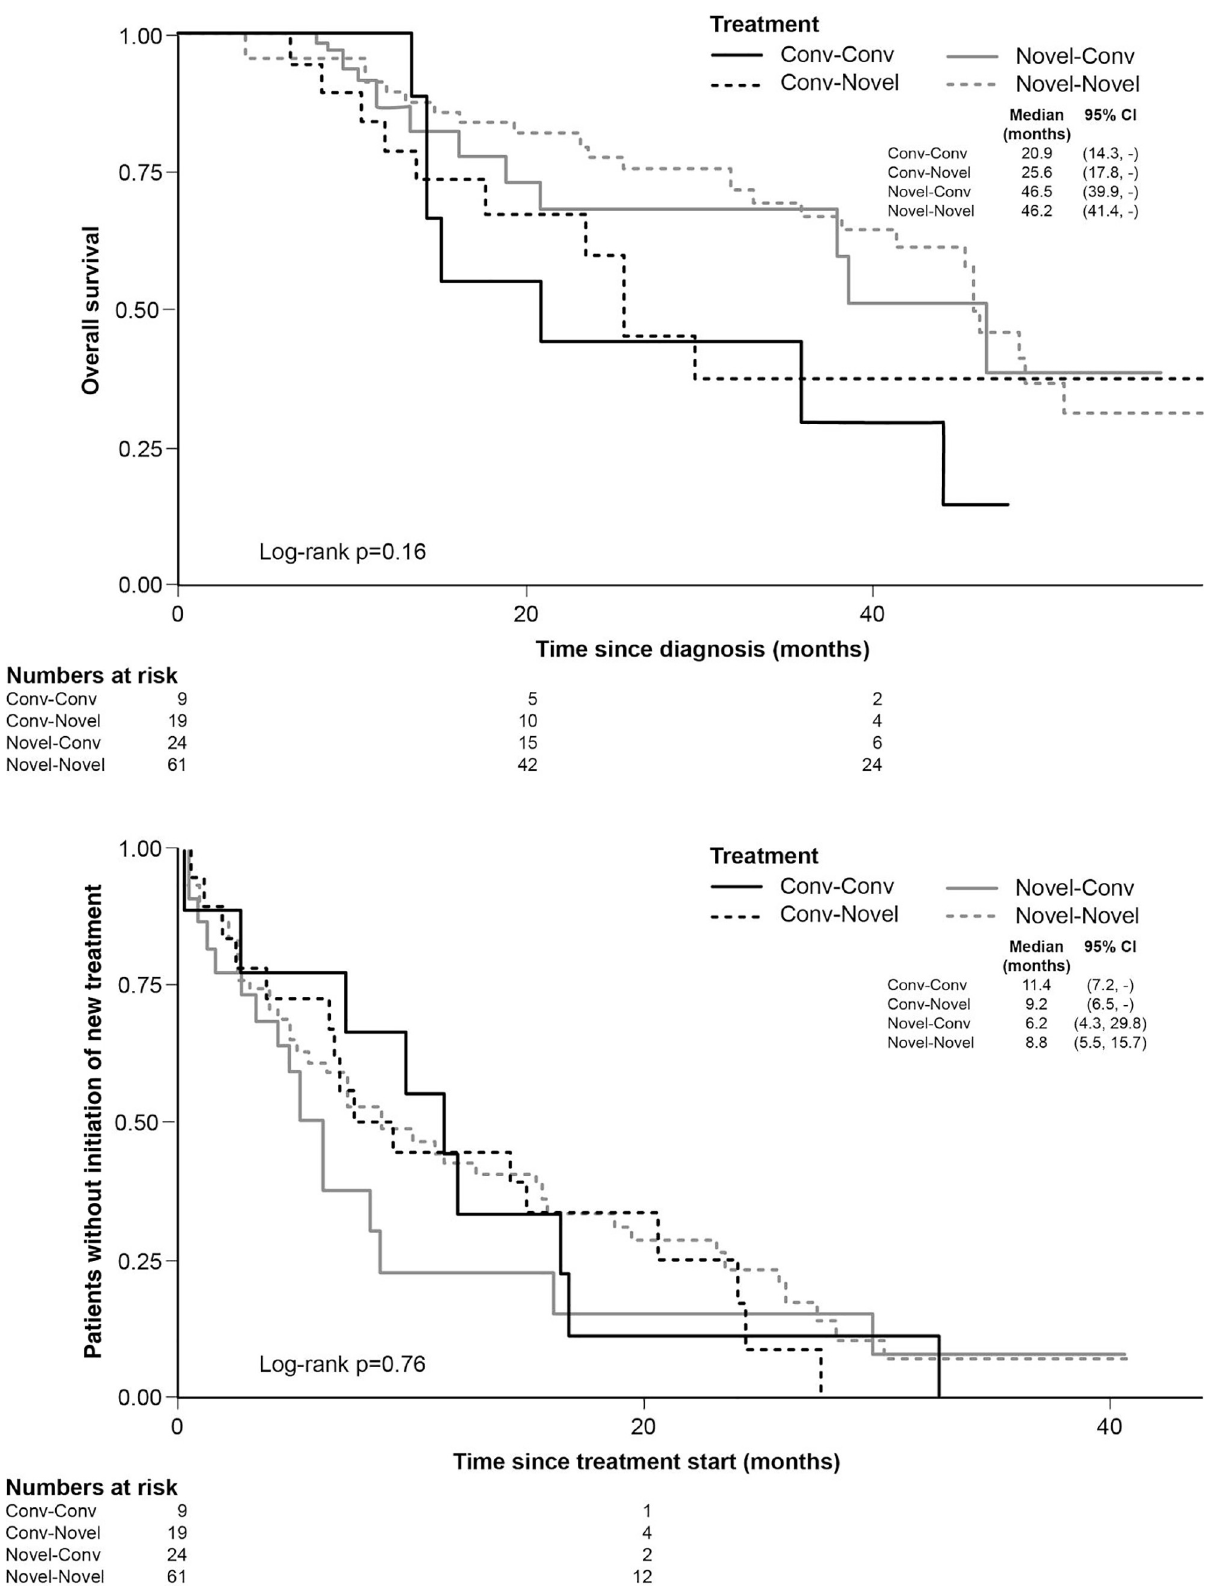
Fig 3. OS (top) and TTNT (bottom) by first-and second-line treatment choice (non-transplant patients only). https://doi.org/10.1371/journal.pone.0208507.g003 PLOS ONE | https://doi.org/10.1371/journal.pone.0208507 December5,